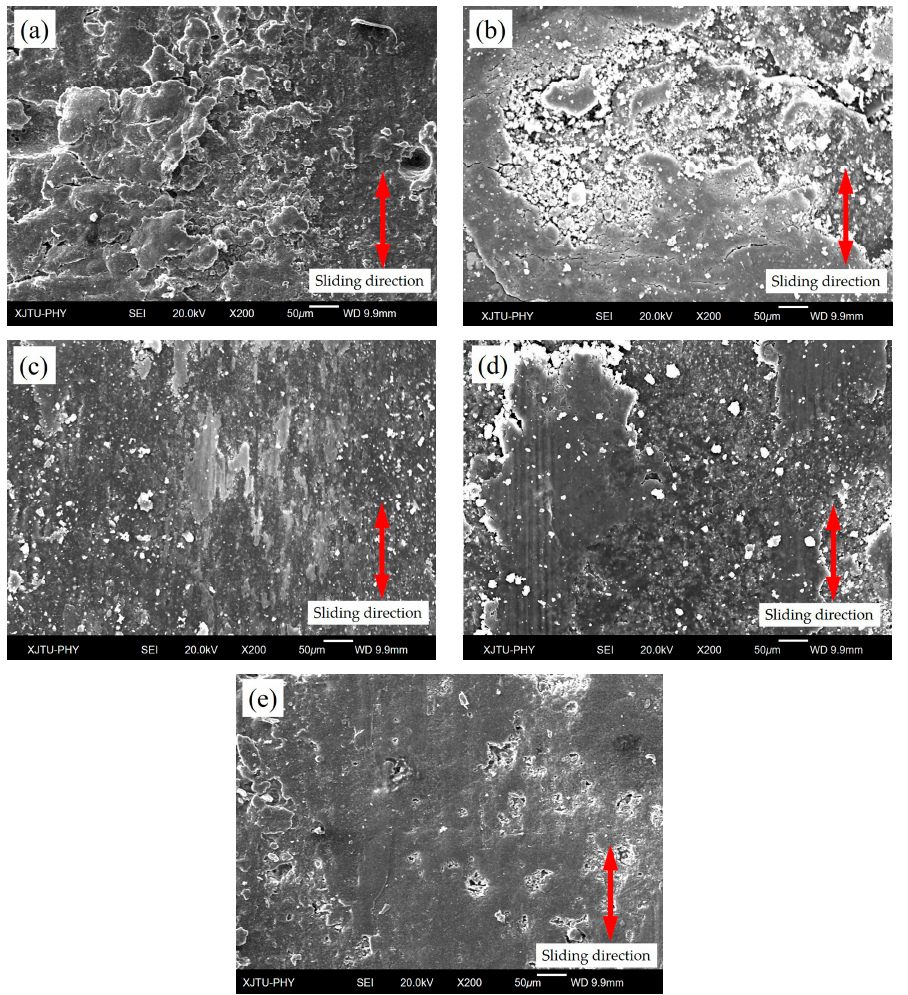
Figure 9. SEM images of worn surfaces of epoxy coating with the graphene content of ( a ) 0.0 wt %, ( b ) 1.0 wt %, ( c ) 2.0 wt %, ( d ) 3.0 wt %, and ( e ) 4.0 wt % respectively under 150 °C.